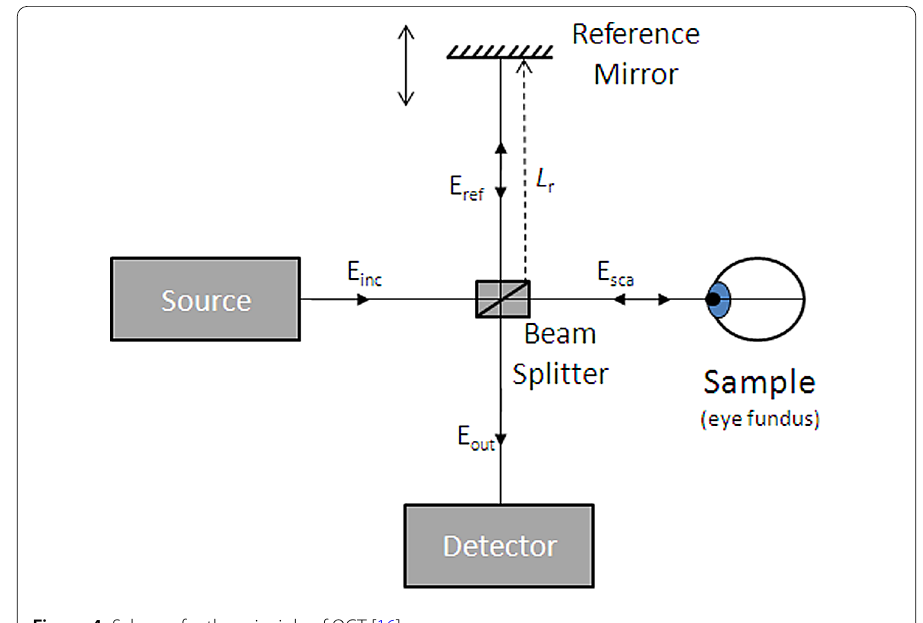
Figure 4 Scheme for the principle of OCT